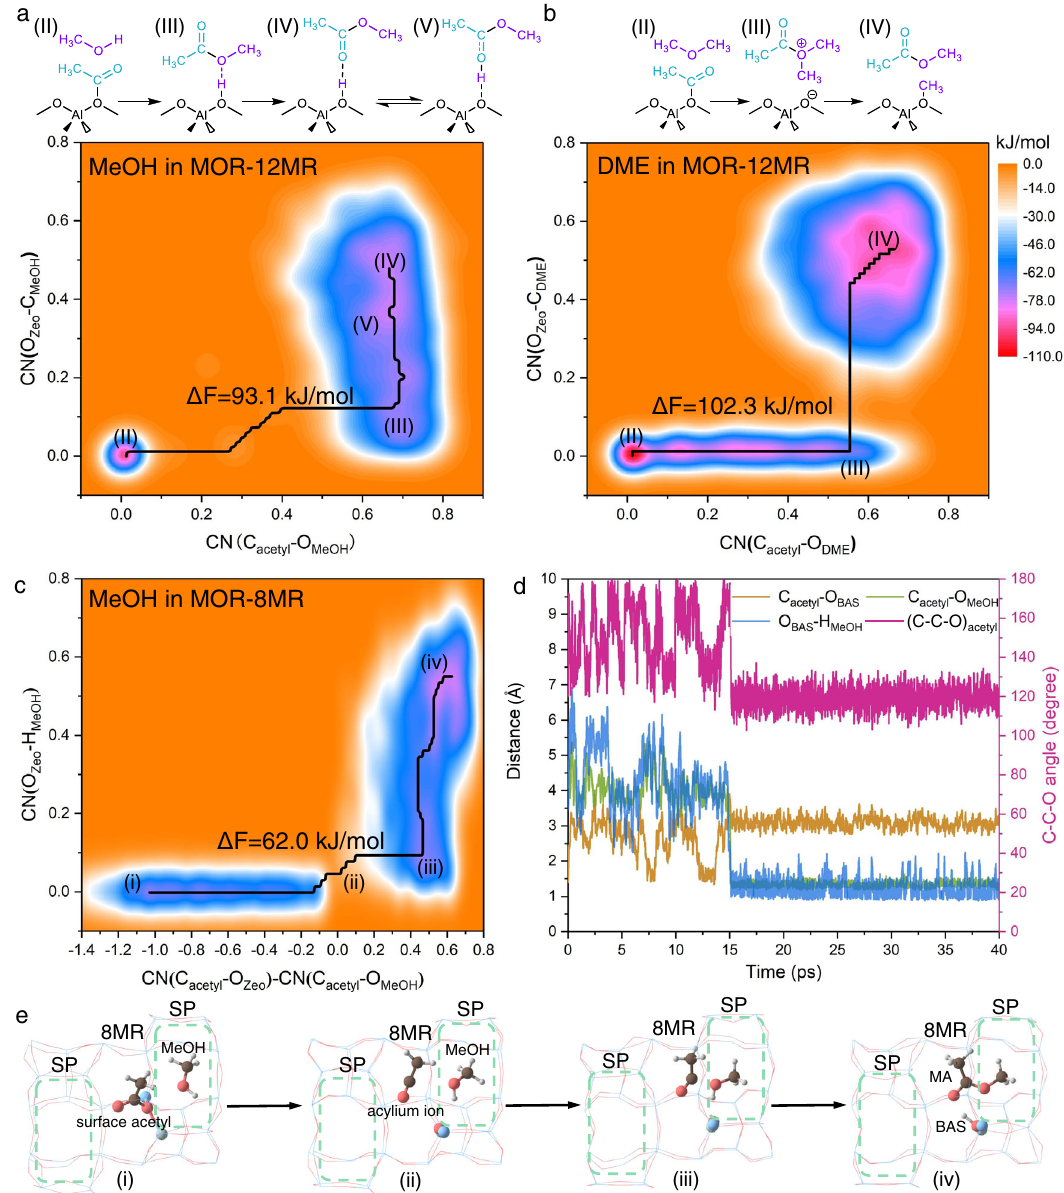
Fig. 2 | Free energy pro fi les (473K) and reaction routes of MA formation. a MeOH+surface acetyl and b DME+surface acetyl in MOR-12MR, c MeOH+surface acetyl in MOR-8MR. d Dynamic evolution of key bond distance and angle and e reaction process of c . SP: side pocket. The structures of (i) – (iv) in e are corresponding to the local minimum of (i) – (iv) in c . The value of Δ F in a – c is free energy barrier in the minimum free energy pathway. CN(C acetyl -O MeOH